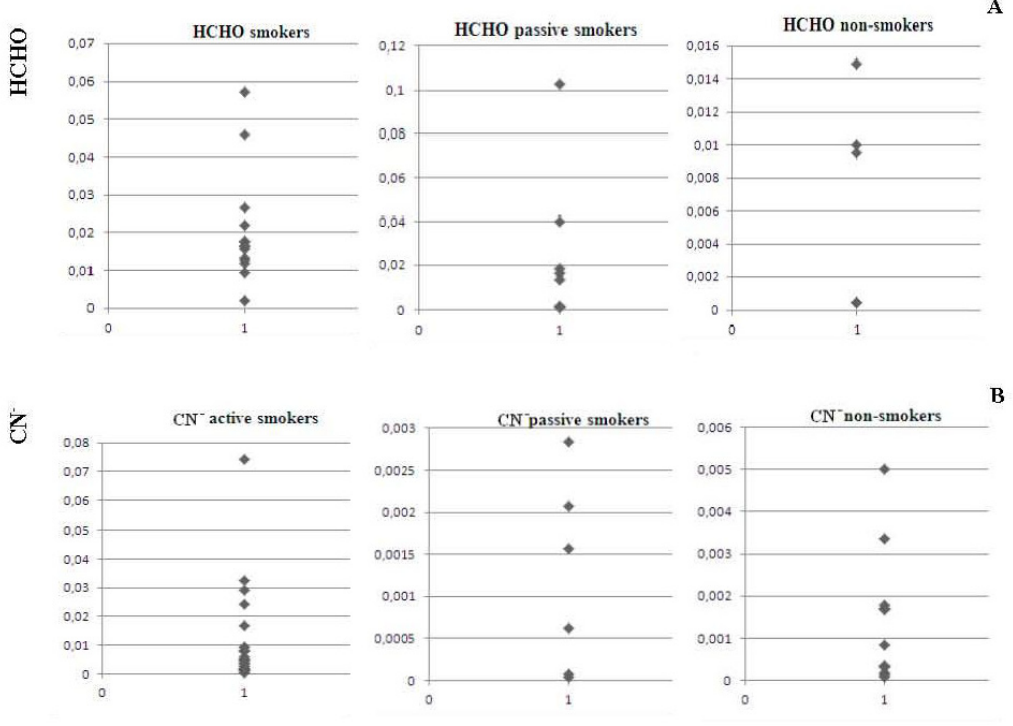
Figure 3. Concentrations of HCHO (A) and ion CN - (B) in the nasal discharge samples collected from non-smokers, passive smokers and smokers. Table